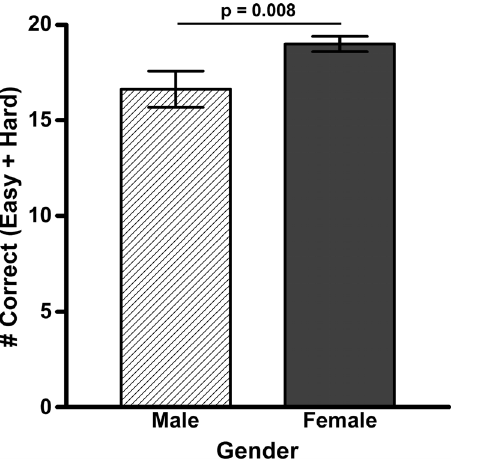
Figure 4. Average d’ for each conversation type. The average d’ score for participants who overheard a one-sided versus